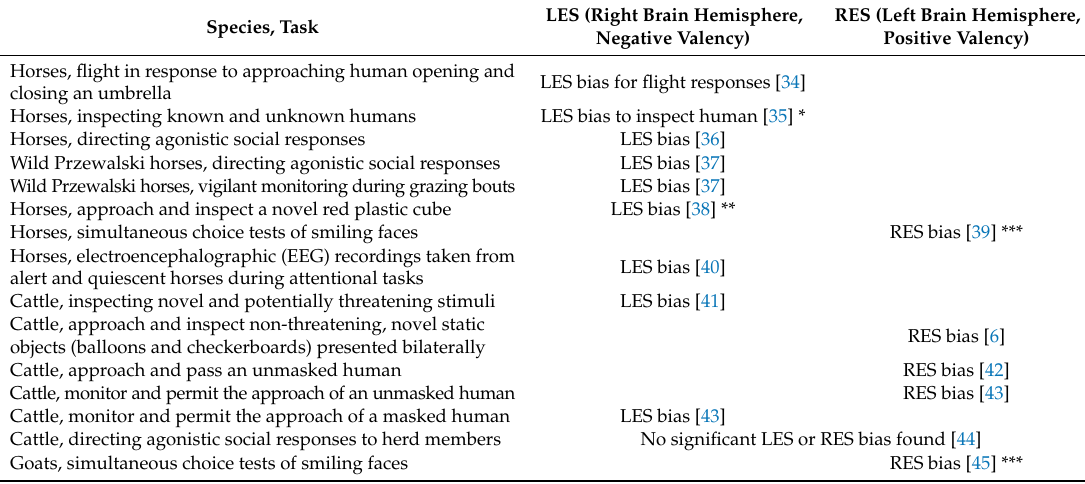
Table 1. Population-level visual preferences in ungulate species responding to specific stimuli. LES and RES represent the left and right eye systems, respectively. Visual input from the separate eye systems is processed in the opposite brain hemisphere, each concerned with primarily negative or positive valency modes of analysis (see text). LES (Right Brain Hemisphere, RES (Left Brain Hemisphere, Species, Task Negative Valency) Positive